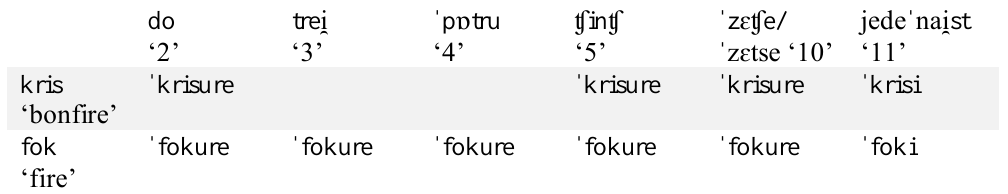
Table 19. Marking of the ‘eleven’ threshold by - i in genus alternans